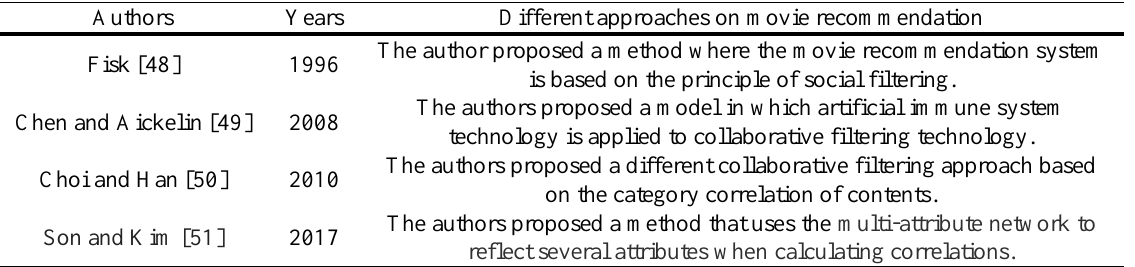
Table 1. A literature review on existing systems.